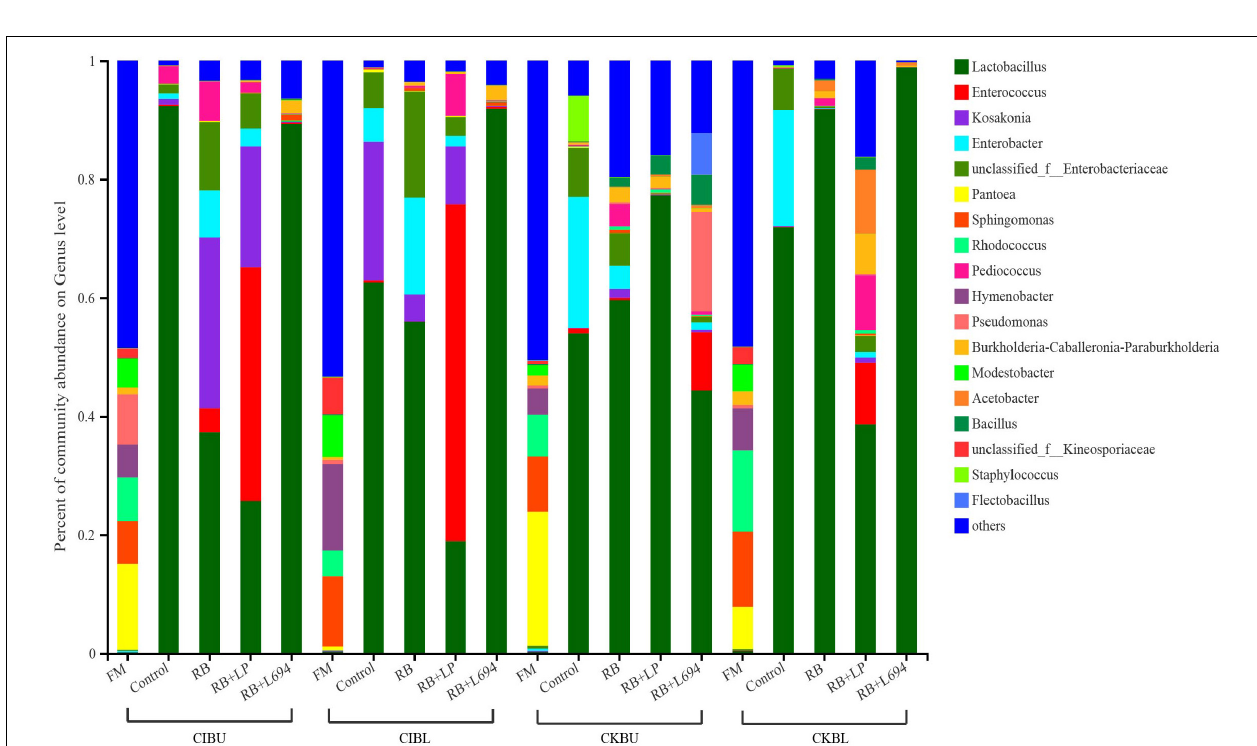
FIGURE 5 | Bacterial communities and relative abundance of Caragana materials and their silages at genus level ( n = 3).